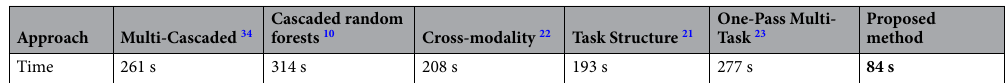
Table 3. Comparison of execution time of different techniques applied on BRATS 2018 dataset for one subject patient.